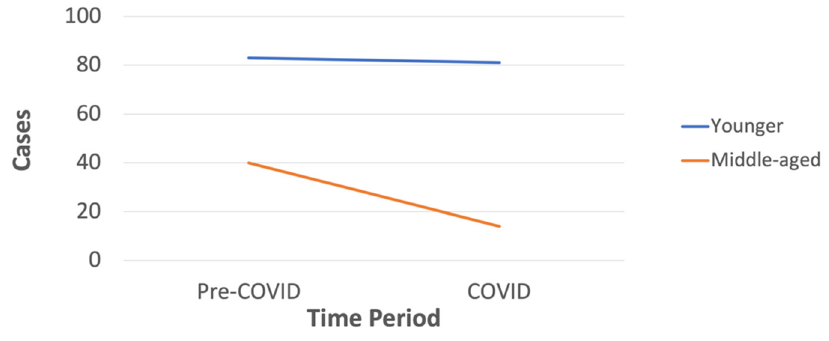
Figure 4. Change in assault-related TBI cases by age group for prison victims between pre-COVID and COVID